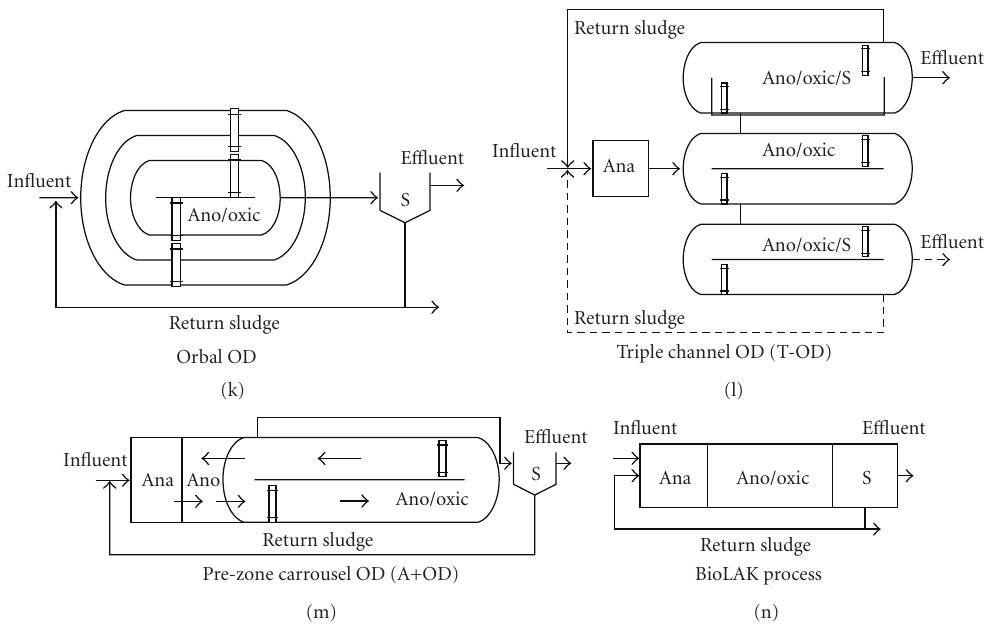
Figure 3: Scheme diagrams of major processes in WWTPs in